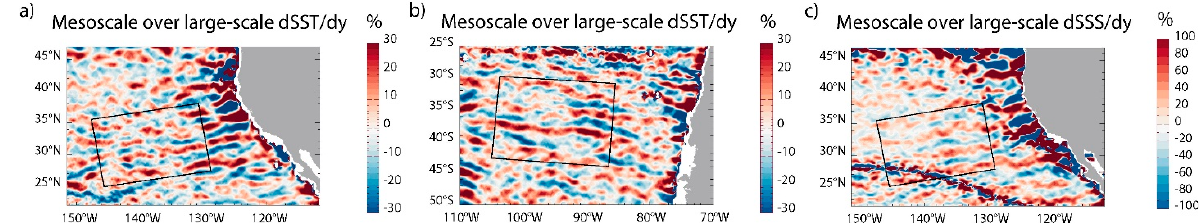
Figure 12. Ratio of spatially high-pass filtered to spatially low-pass filtered time-averaged meridional gradient of ( a , b ) AMSR-2 SST and ( c ) SMAP SSS in the ( a , c ) ENP and ( b ) ESP. The tilted boxes on ( a , c ) and ( b ) are the same as in Figures 2a,c and 3a, respectively.